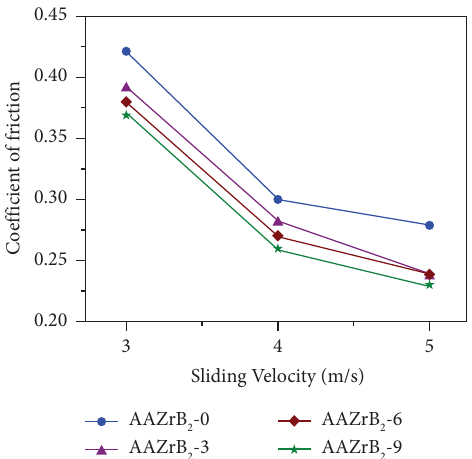
Figure 2: The sliding velocity affecting the coefficient of friction for both pure and hybridized composite samples. Table 5: Taguchi orthogonal arrangement for AAZrB